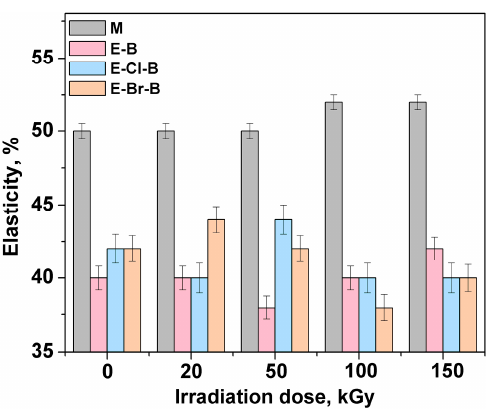
Figure 1. Hardness versus electron beam irradiation dose for EPDM/butyl rubber samples.